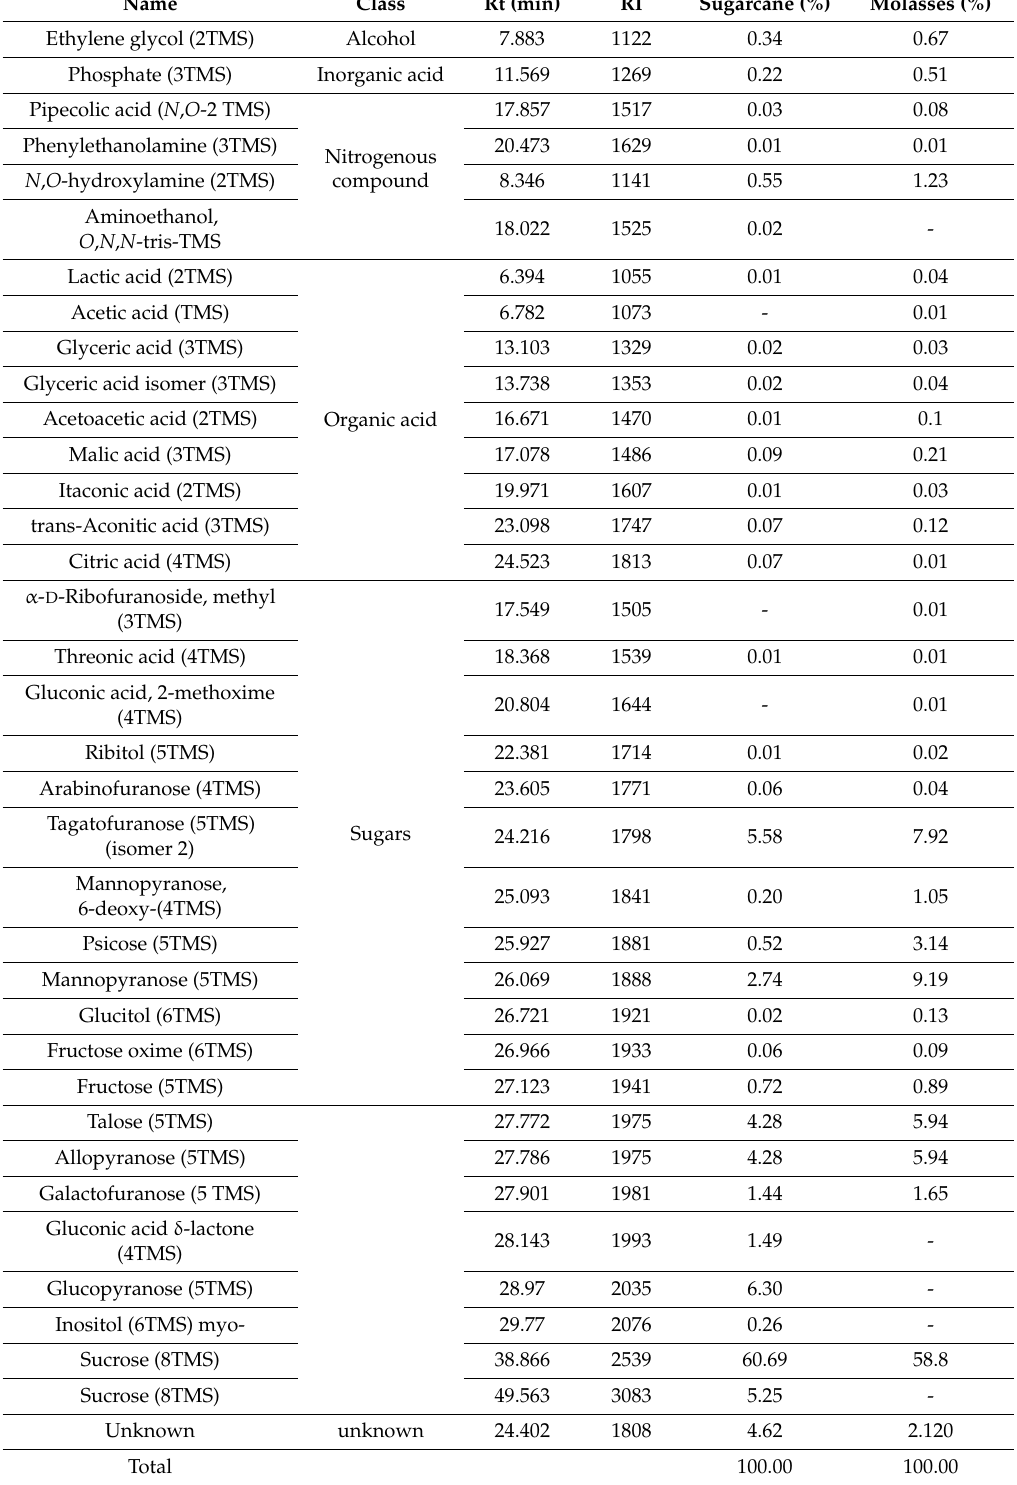
Table 2. The identity, retention time (Rt), retention index (RI) and percentile levels (%) of primary silylated metabolites in sugarcane juice and molasses via GC/MS analysis ( n =